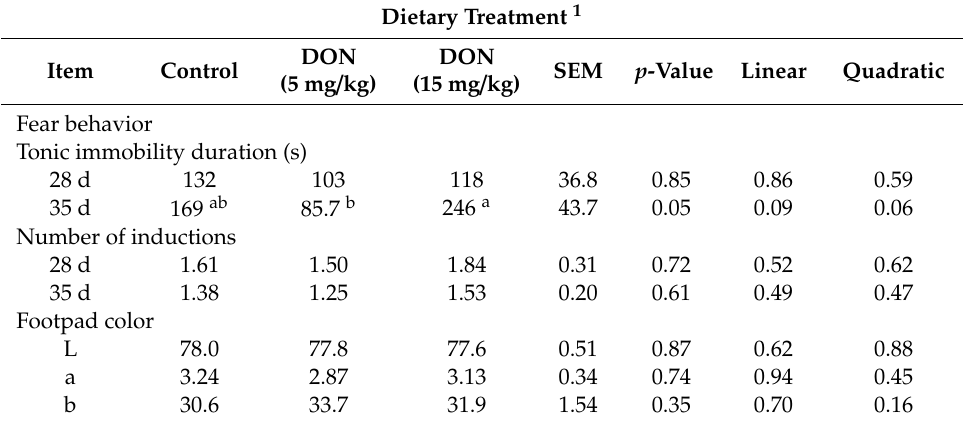
Table 7. E ff ects of DON-contaminated feed (5 and 15 mg / kg) on welfare parameters of broiler chickens. Dietary Treatment